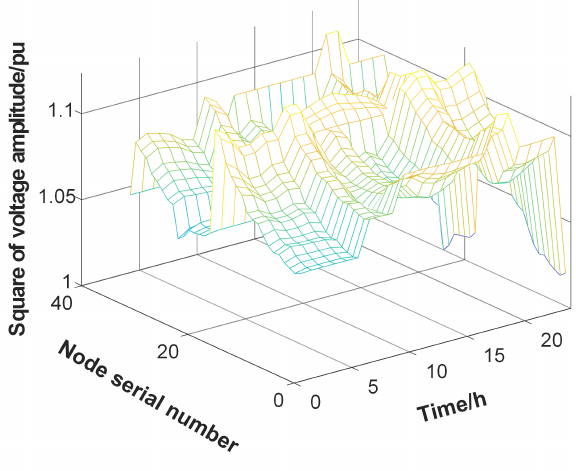
Fig. 13. Voltage distribution before regulation